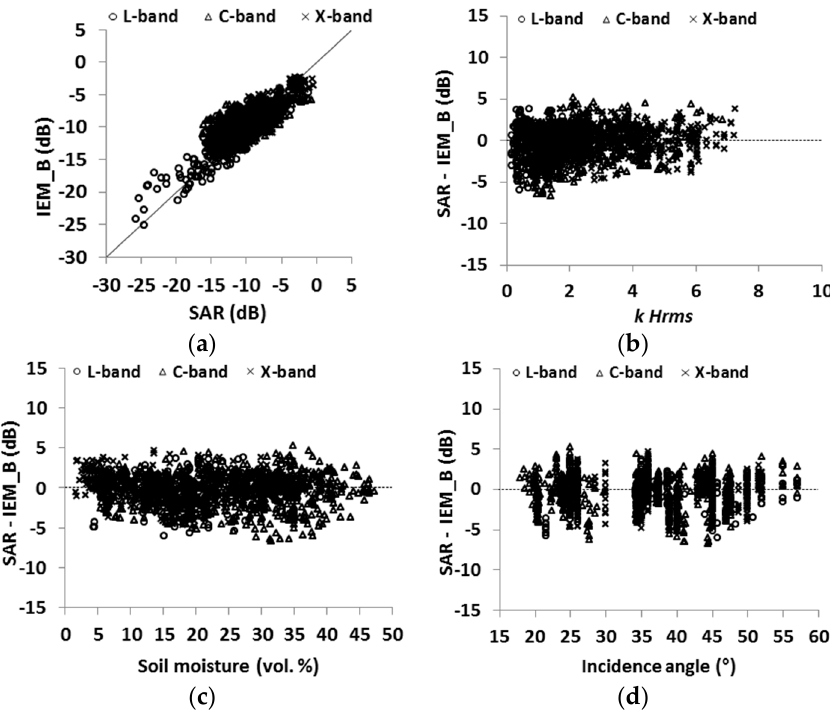
Figure 12. Comparison between backscattering coefficients derived from SAR images and those estimated from IEM_B at HH polarization using GCF. ( a ) IEM_B simulations vs. SAR data; ( b ) difference between SAR signal and IEM_B vs. soil roughness ( kHrms ); ( c ) difference between SAR signal and IEM_B vs. soil moisture ( mv ); ( d ) difference between SAR signal and IEM_B vs. incidence angle.